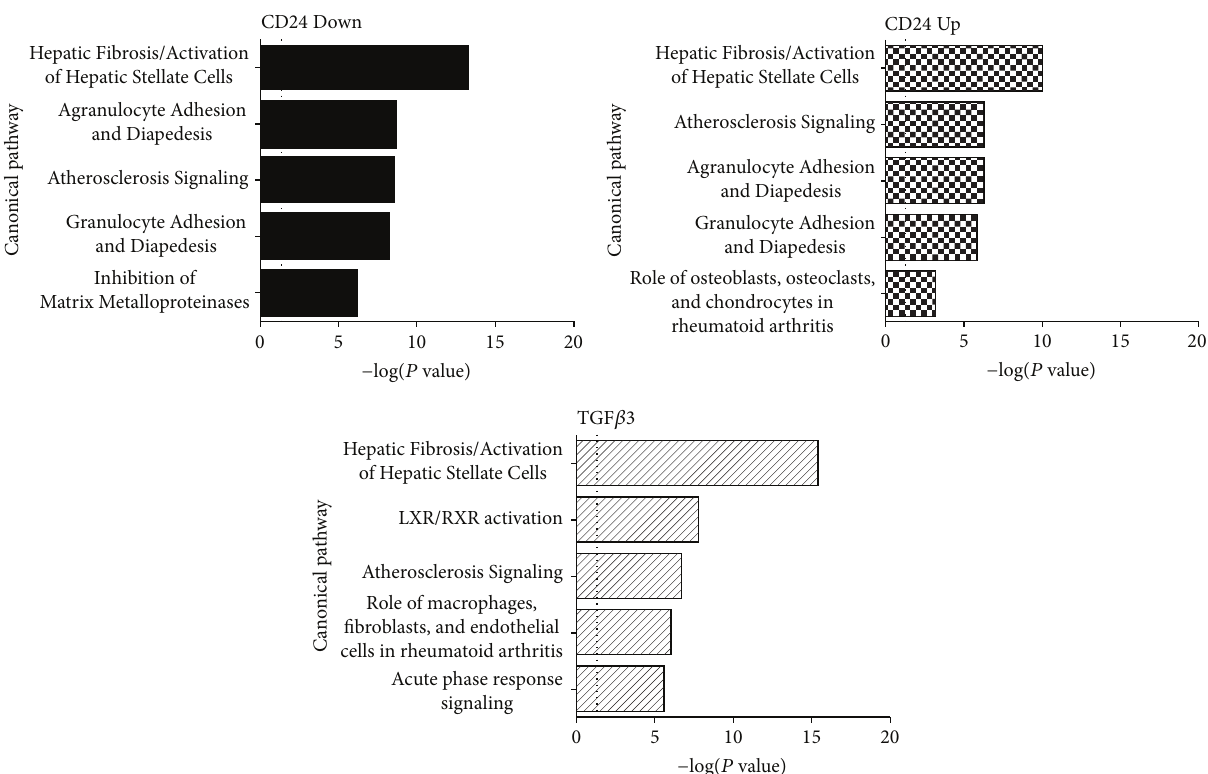
Figure 4: Biological functions influenced by CD24 and TGF 𝛽 3. The top five canonical pathways regulated by knockdown of CD24 (CD24 Down), overexpression of CD24 (CD24 Up), or stimulation with TGF 𝛽 3 (TGF 𝛽 3) in hBMSCs based on their significance ( 𝑃 value) calculated by Ingenuity Pathway Analysis using the right-tailed Fisher’s Exact Test using the entire data set. The dotted line is the threshold value with 𝑃 = 0.05 .